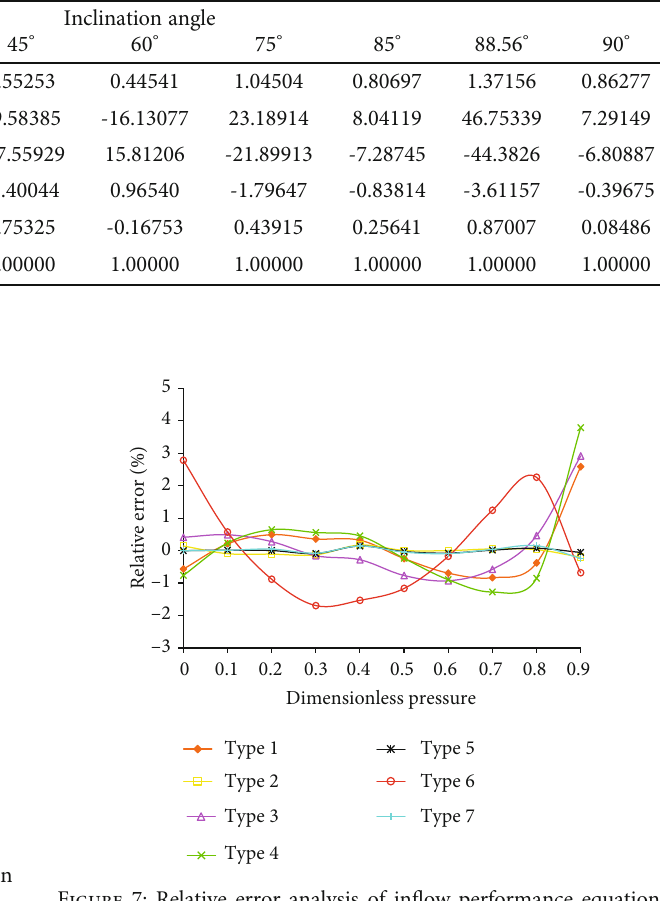
Figure 7: Relative error analysis of in fl ow performance equation fi tting for seven types of 85 ° inclined wells.